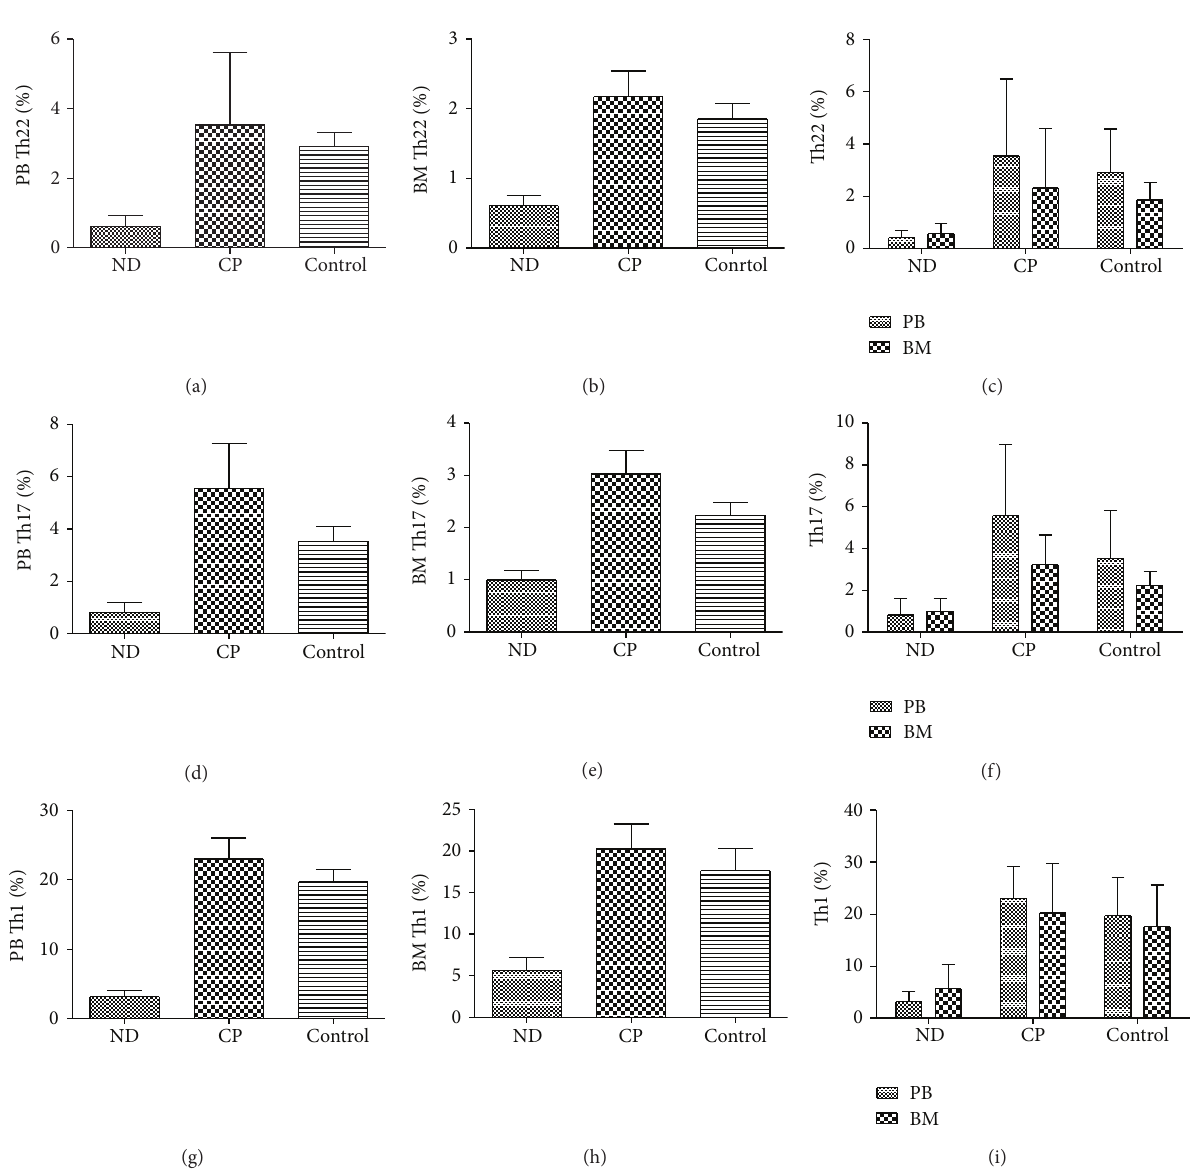
Figure 2: Percentages of Th17, Th22, and Th1 cells in CML patients and healthy controls. (a) Percentages of PB Th22 cells from CML patients and healthy controls. Significantly decreased percentages of Th22 cells were found in ND patients compared to CP patients ( ∗ 𝑃 = 0.029 ) or healthy controls ( ∗ 𝑃 = 0.005 ). (b) Percentages of BM Th22 cells from CML patients and healthy controls. Significantly decreased percentages of Th22 cells were found in ND patients compared to CP patients ( ∗ 𝑃 = 0.009 ) or healthy controls ( ∗ 𝑃 = 0.037 ). (c) Percentages of Th22 cells in PB or BM of ND patients, CP patients, and healthy controls. No significant differences were found between PB and BM. (d) Percentages of Th17 cells from CML patients and healthy controls. The circulating percentages of Th17 cells were profoundly decreased in ND patients compared to CP patients ( ∗ 𝑃 = 0.005 ) or healthy controls ( ∗ 𝑃 = 0.029 ). (e) The percentages of Th17 cells in BM of ND patients was proudly decreased compared to CP patients ( ∗ 𝑃 = 0.000 ) or healthy controls ( ∗ 𝑃 = 0.008 ). (f) There were no differences in the percentages of Th22 cells between PB or BM in ND patients, CP patients and healthy controls. (g) Percentages of Th1 cells from CML patients and healthy controls. The percentages of Th1 cells in PB of ND patients were proudly decreased compared to CP patients ( ∗ 𝑃 = 0.001 ) or healthy controls ( ∗ 𝑃 = 0.001 ). (h) The frequencies of Th1 cells in BM of ND patients, CP patients, and healthy controls. The frequency of Th1 cells in BM of ND patients was also significantly decreased compared to CP patients ( ∗ 𝑃 = 0.01 ) or healthy controls ( ∗ 𝑃 = 0.02 ). (i) The percentages of Th1 cells in PB or BM were not statistically different in ND patients, CP patients, and healthy